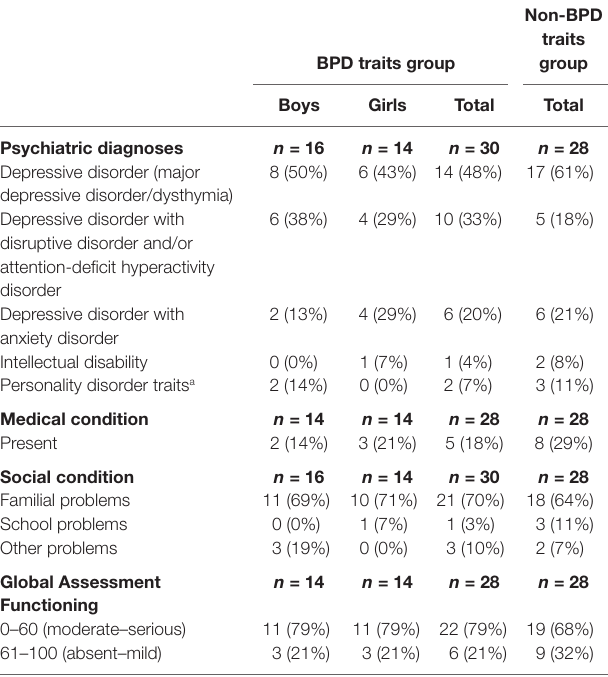
TaBle 1 | DsM-5 diagnoses and associated